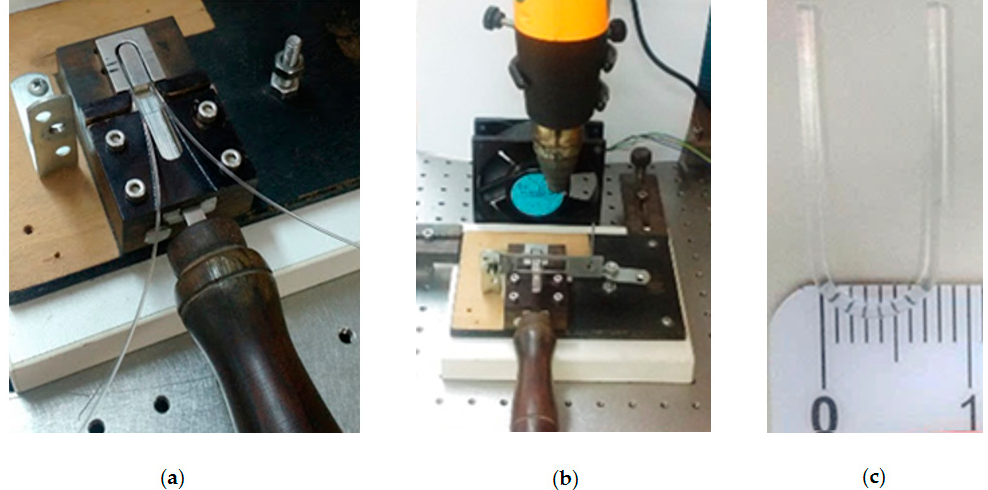
Figure 3. ( a ) Bare U-shaped POF probes installed inside the vacuum sputtering chamber 10 cm above gold target and tilted 45° from vertical; ( b ) U-shaped POF probes coated with 70 nm gold thin film; ( c ) Custom-made device used to cleave the probe ends; ( d ) End faces were polished with a 3 μ m polish film in “figure of eight”